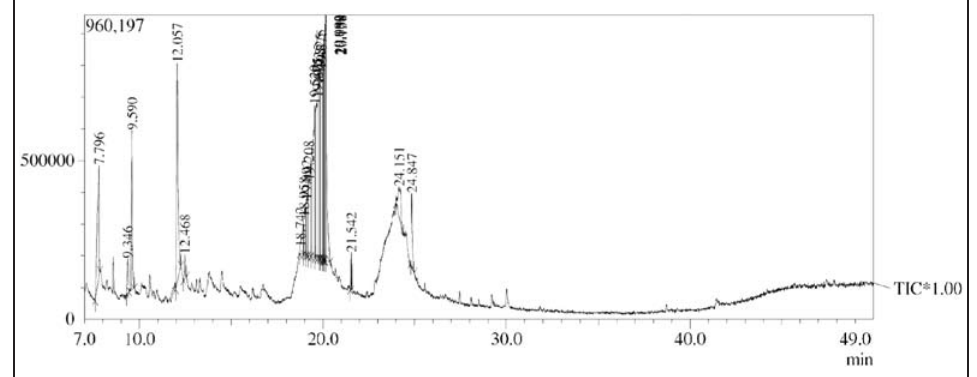
Fig. 3. GC-MS chromatogram of methanol extract of C. nurvala